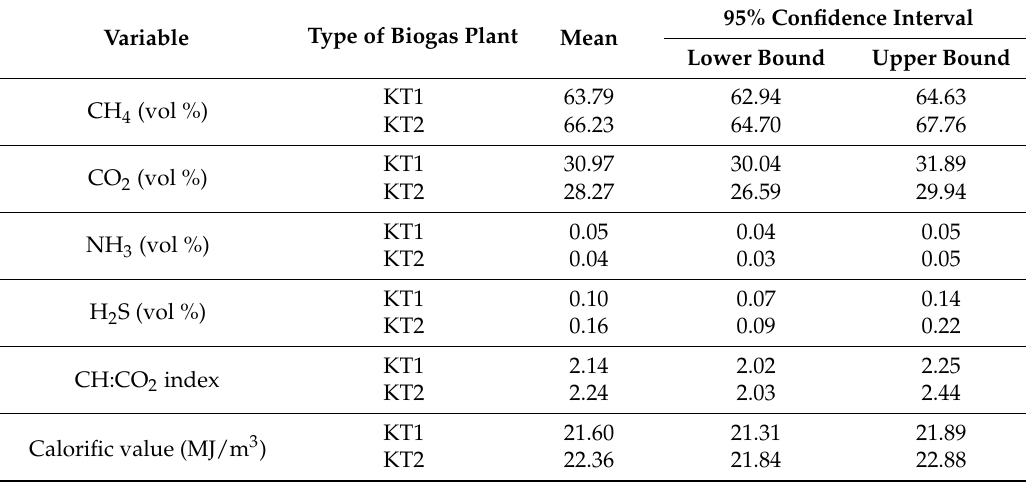
Table 3. Biogas composition according to the type of biogas plant, KT1 ( n = 83) and KT2 ( n =